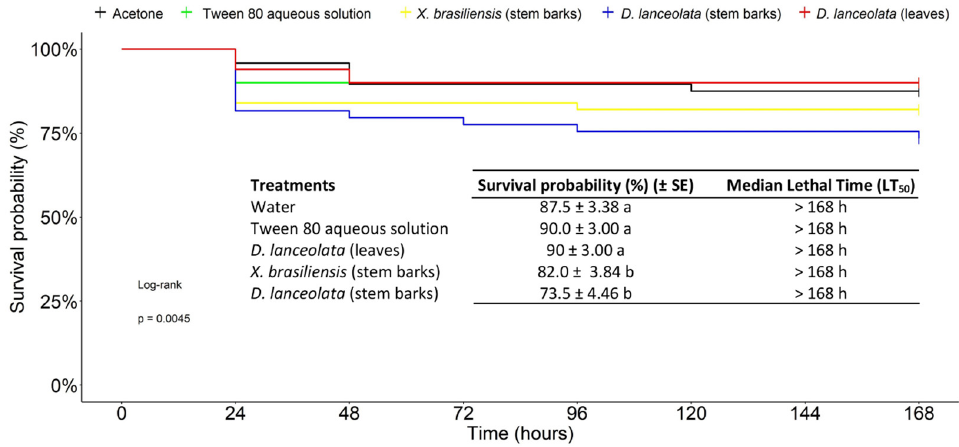
Figure 4. Survival analysis of Spodoptera frugiperda caterpillars offered an artificial diet containing essential oils from Duguetia lanceolata (leaves and stem barks) and Xylopia brasiliensis (stem bark). The same letters do not differ statistically by Pairwise multiple comparison test.